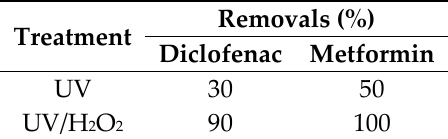
Table 2. Results of efficiency removals of DIC and MET after UV treatments.